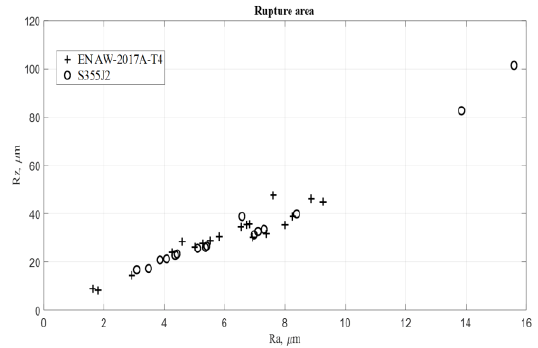
Fig. 9. The relationship between Rz and Ra of rupture area.